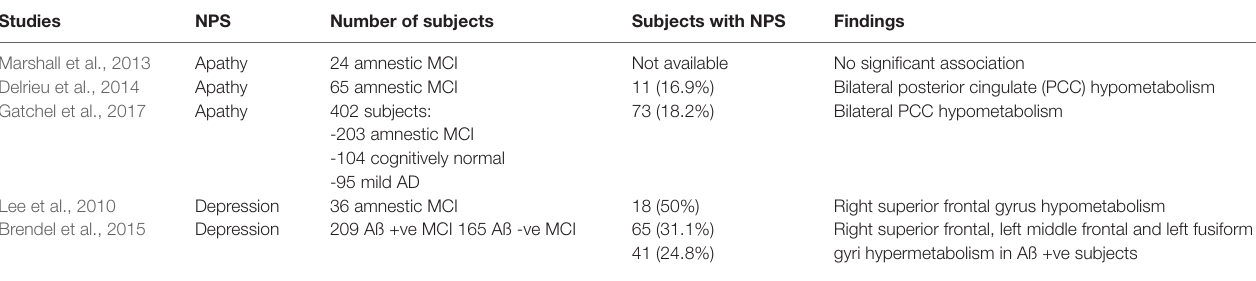
TABLE 2 | Metabolic dysfunction and NPS in preclinical AD and MCI